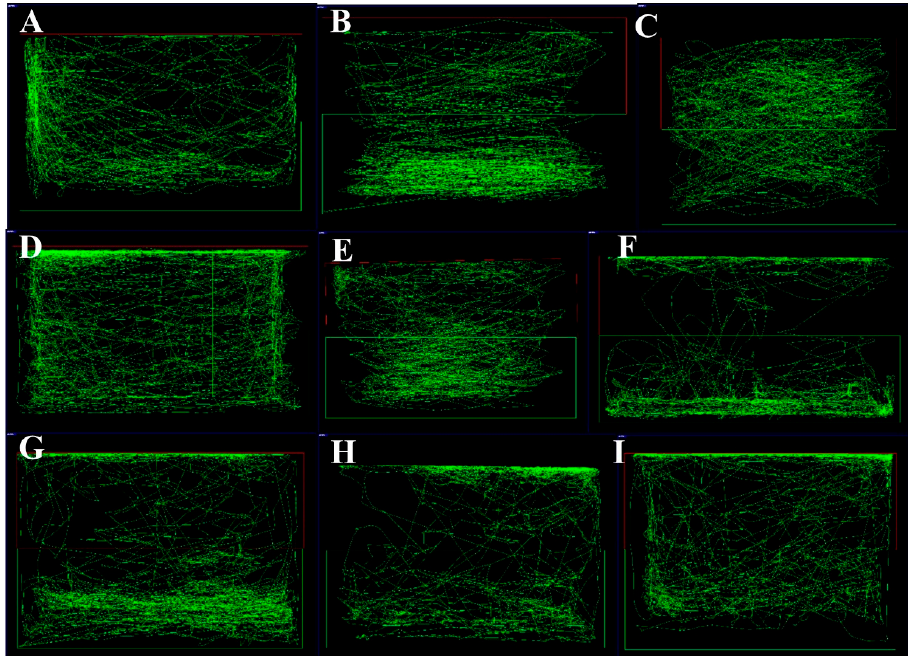
Figure 2. Representative images of zebrafish swimming pattern for various groups tested for behavioral effects of Piper methysticum stem extracts: ( A ) pentylenetetrazol (PTZ) (170 mg / kg) − negative control, ( B ) diazepam (DZP) (10 mg / L) + PTZ (170 mg / kg) − positive control, ( C ) vehicle control, ( D ) stems with no peels (SNPA) (100 mg / kg), ( E ) SNPA (50 mg / kg), ( F ) whole stems (SWA) (50 mg / kg), ( G ) SWA (25 mg / kg), ( H ) stem peels (SPA) (50 mg / kg), ( I ) SPA (25 mg /